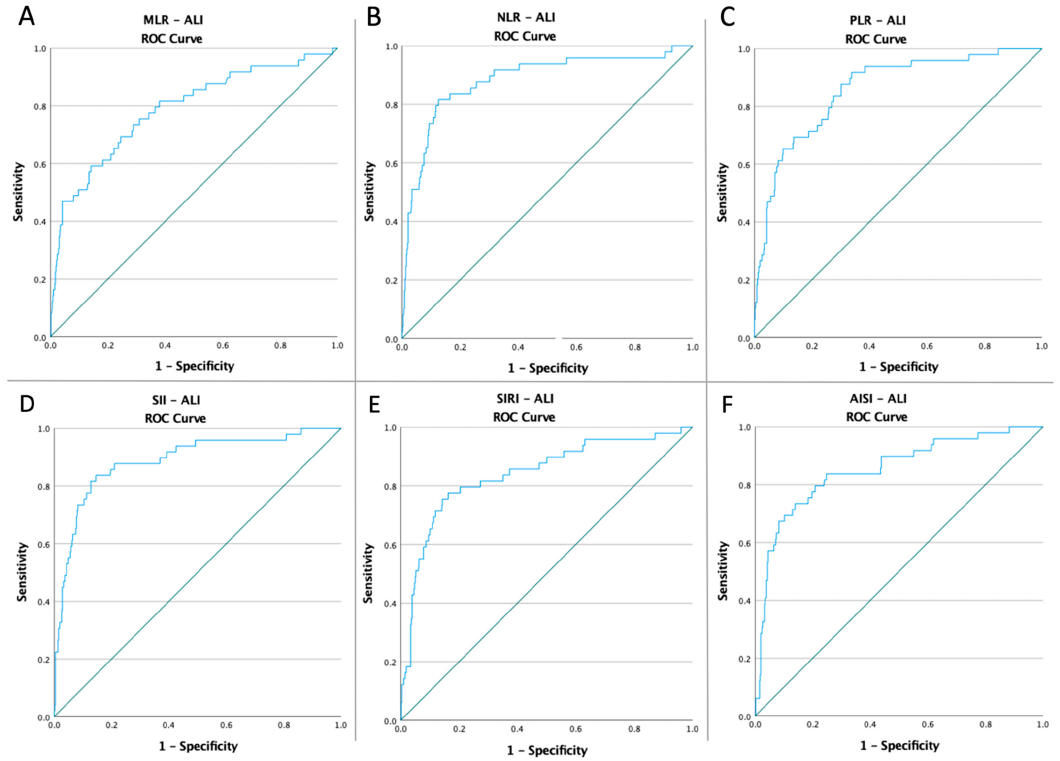
Figure 1. ROC curve analysis concerning the ALI risk ( A ) MLR (AUC: 0.829; p < 0.0001), ( B ) NLR (AUC: 0.856; p < 0.0001), ( C ) SII (AUC: 0.858; p < 0.0001), ( D ) SIRI (AUC: 0.785; p < 0.0001), ( E ) AISI